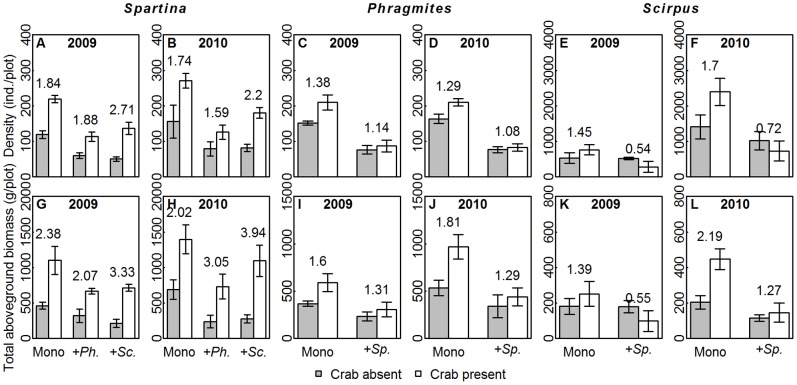
The plant performance at plot-level.The density (mean ± SE, A–F) and total aboveground biomass (mean±SE, G–L) per plot of three species with/without crab disturbance in five species combinations are presented. The categories on X axis present different species combinations. “Mono”, “+Sp.”, “+Ph.” and “+Sc.” are abbreviations for “monocultures”, “with Spartina”, “with Phragmites” and “with Scirpus”, respectively. The Rcrabs of three species in specific species combinations are given above the bars.